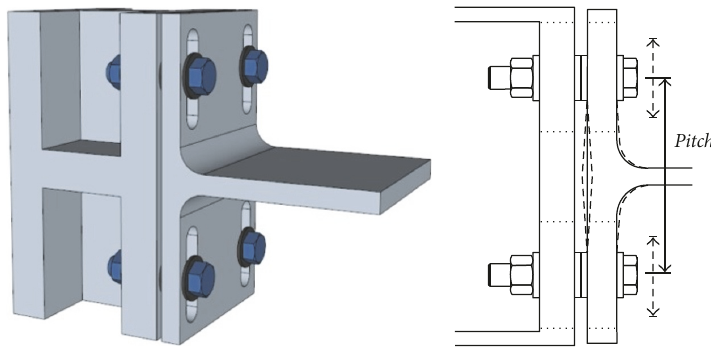
Figure 5: Force-displacement curves of the MHD without the lead rubber bearing; friction variation according to (a) the number of high- tensile bolts and (b) tightening torques.